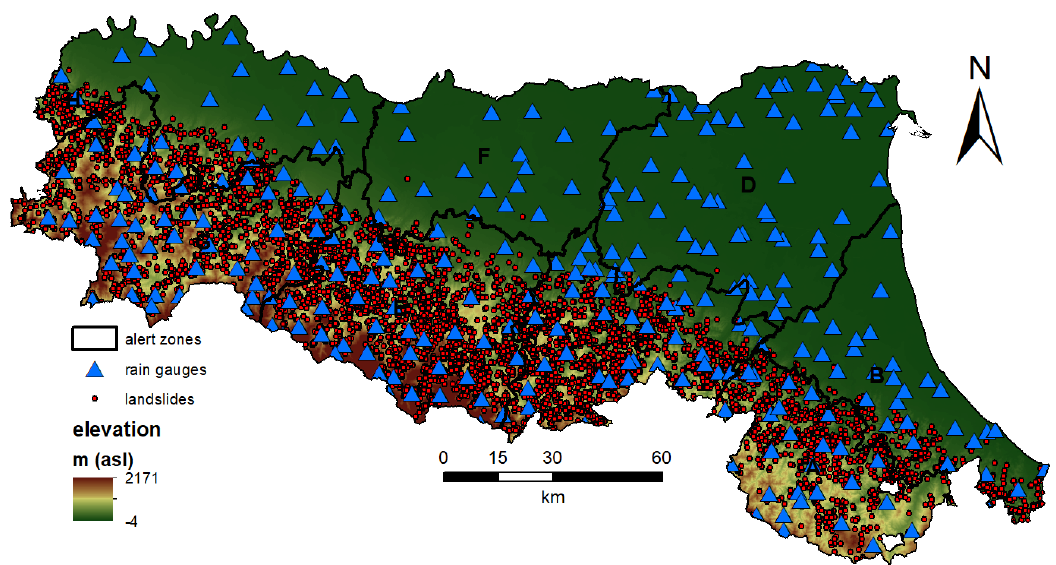
Figure 1. Map of the Emilia Romagna Region showing both landslide and rain gauges distribution.